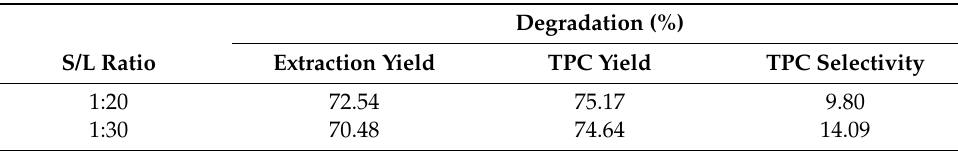
Table 1. Temperature-related degradation: percent losses of yield and TPC for re-irradiated samples (from 150 ◦ C to 220 ◦